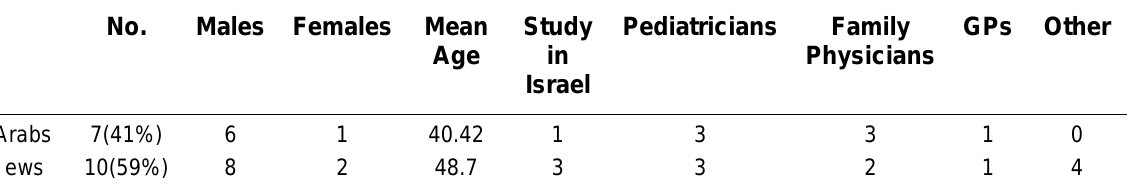
Demographics of the Sample